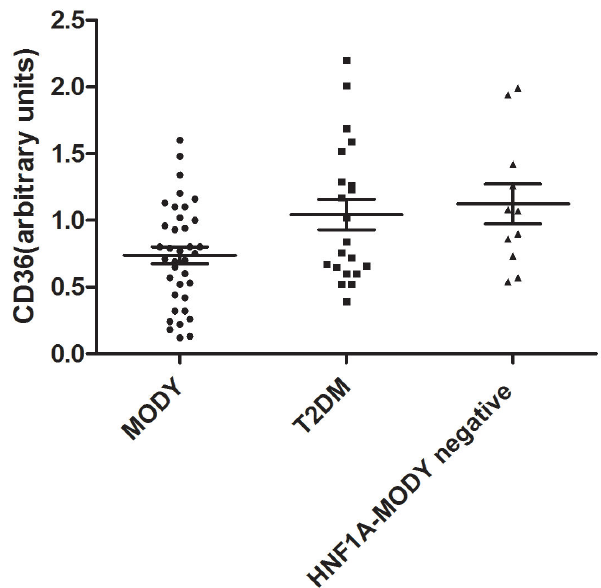
Figure 1. sCD36 (arbitrary units) in HNF1A-MODY (black circle), T2DM (black square) and HNF1A-MODY negative normoglycaemic control (black triangle). BMI=Body Mass Index, SBP=Systolic Blood Pressure, DBP=Diastolic Blood Pressure, HDL=High density Lipoprotein, TG=Triglycerides, LDL=Low Density Lipoprotein, OGIS=Oral Glucose Insulin Sensitivity Index. hsCRP=high sensitivity C- reactive protein.ALT=Alanine aminotransferase.